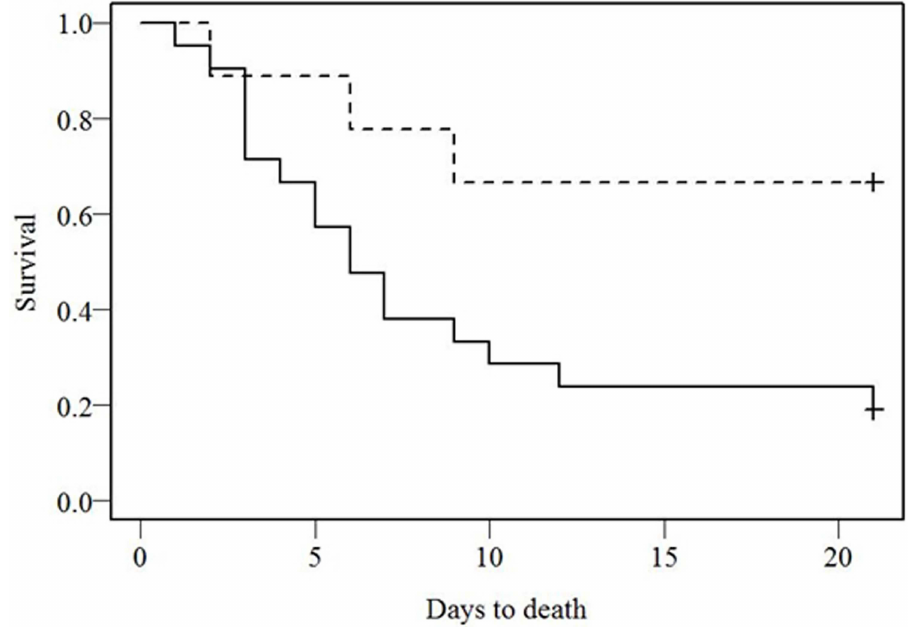
Fig 2. IFN β -1atreatment effect on survival of patients with EVD. Survivalcurves for patients with EVD receivingsupportivecare only (n = 21) (solidline) or supportive care plus IFN β -1a treatment (n = 9) (dashed line). Survivalwas calculatedfrom the date of consent for those receivingIFN β -1a treatment and date of admissionfor those in the control cohort, to the date of death. Survivalplots were based on Kaplan-Meier estimates and the plots were comparedusing the log rank test (p =